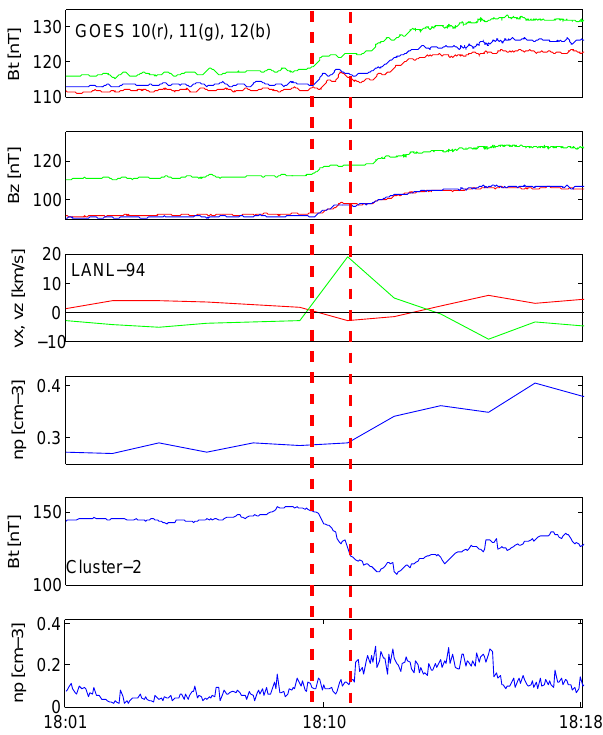
Figure 1. 19 November 2007: the first and second panels show the GOES-10, 11, and 12 (at 14.4, 9.3, and 13.3MLT) total magnetic field and z component of the magnetic field B t [nT] and B z [nT] in the GSM (Geocentric Solar Magnetospheric) coordinate system. The third and fourth panels show LANL-1994 observation of the velocity v x (the red line), v z (the green line) [kms − 1 ] and the par- tial density of high energy ions (0.13–45keVe − 1 ) n p [cm − 3 ]. The penultimate panel shows Cluster-2 total magnetic field B t [nT]. The last panel shows Cluster-4 proton density n p [cm − 3 ]. The first red dashed line represents the time of the first compression and the sec- ond red dashed line depicts the time of the magnetic field decrease, as observed by GOES-10 and 12.